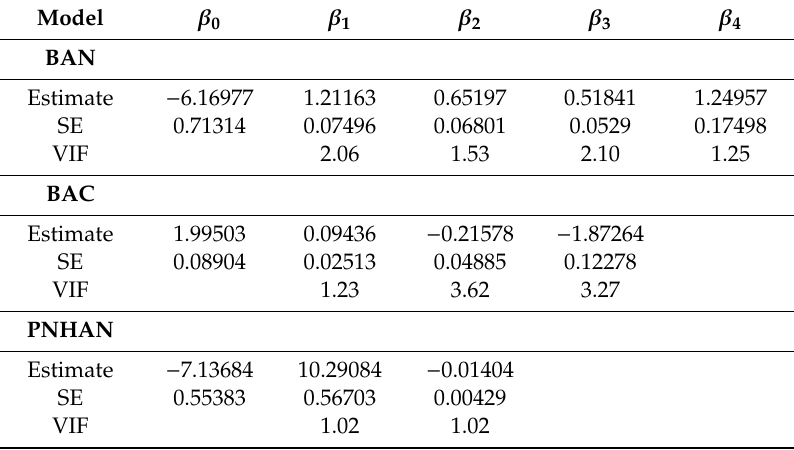
Table 4. Parameter estimate, standard error (SE) and variance inflation factor (VIF) for models of basal area of Nothofagus species (BAN, Equations (7) and (9)), basal area of companion species (BAC, Equations (8) and (10)), and the proportion of number of Nothofagus species trees (PNHAN, Equation (11)). All model parameters were found to be significant ( p <